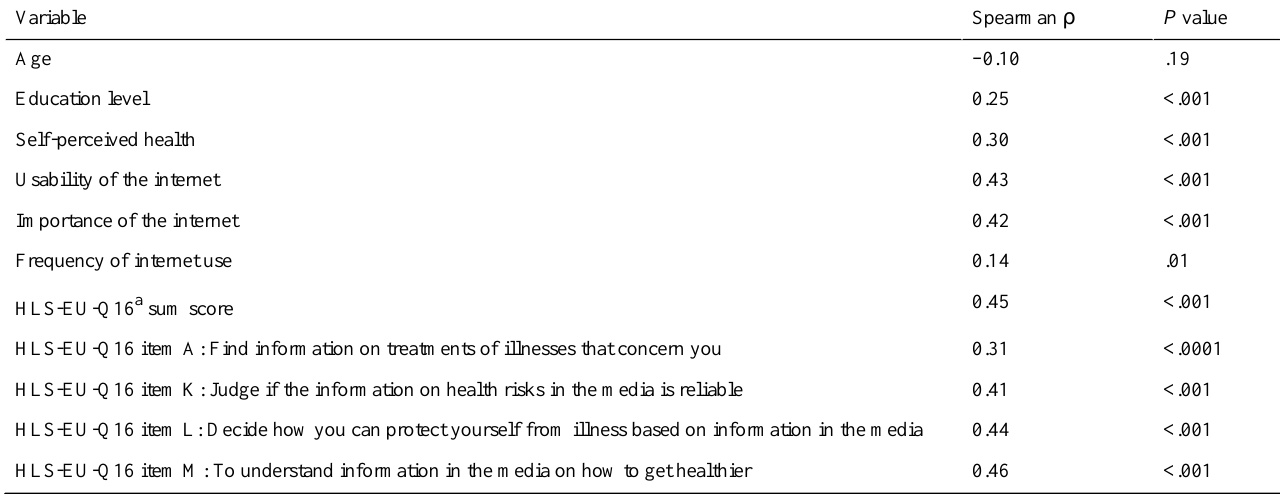
P valueSpearman ρ